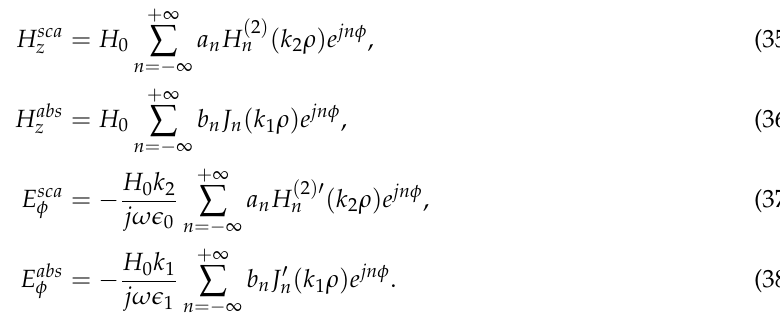
( k ) / I TM ( k ) ) current based on 2 a 1 a ext ext ( k ) / Z TM ( k ) represents 2 a 1 a int int ( k ) is the external impedance of 2 a ext